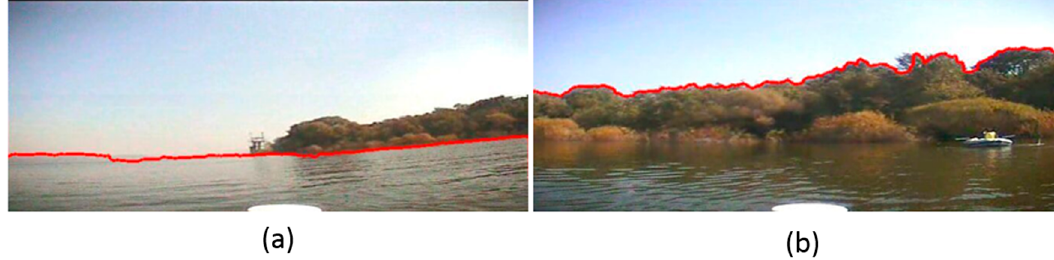
Figure 25. Waterline detection with super pixel segmentation using the same images as Figures 16a and 20a used to test our method in this paper. ( a ) The waterline detection using the same image as Figure 16a; ( b ) The waterline detection using the same image as Figure 20a.